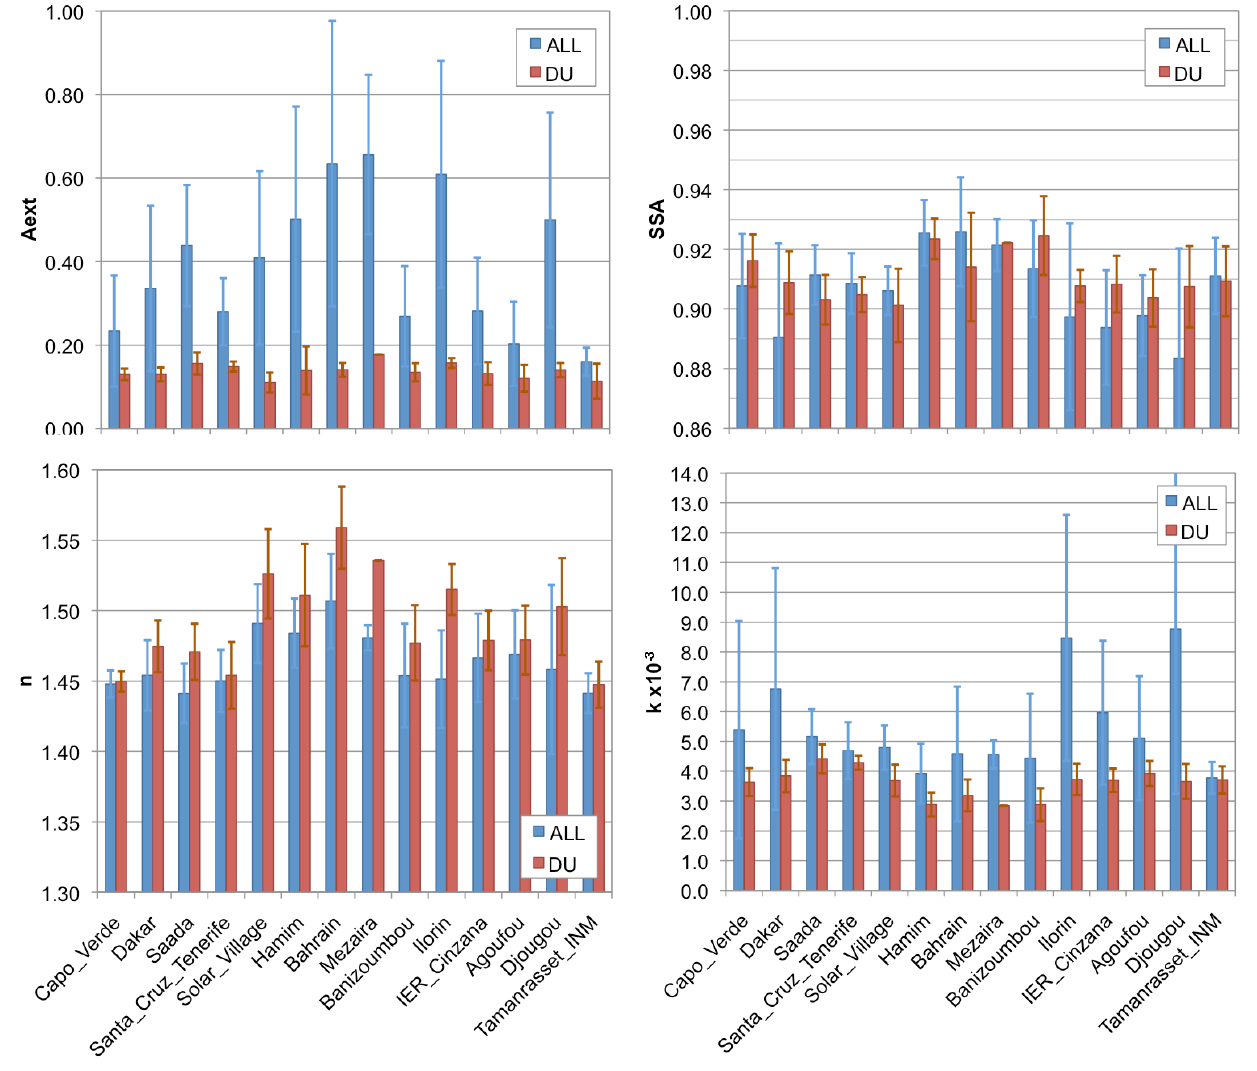
Fig. 4. Annual mean and standard deviation of ˚A ext (440–870nm) and optical properties at 440nm at all considered